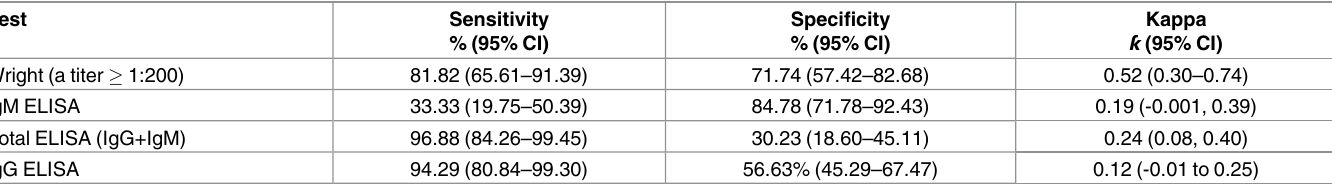
Table 3. Sensitivity, specificity, and Kappa values of serological tests compared with blood culture (the gold standard) for brucellosis diagnosis.